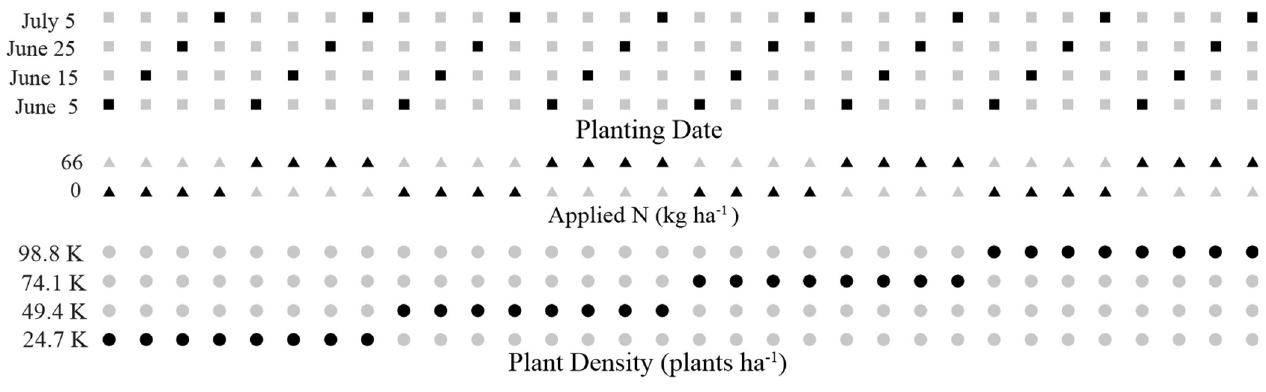
TABLE 1 | The 32 management options modeled in the CERES-Sorghum